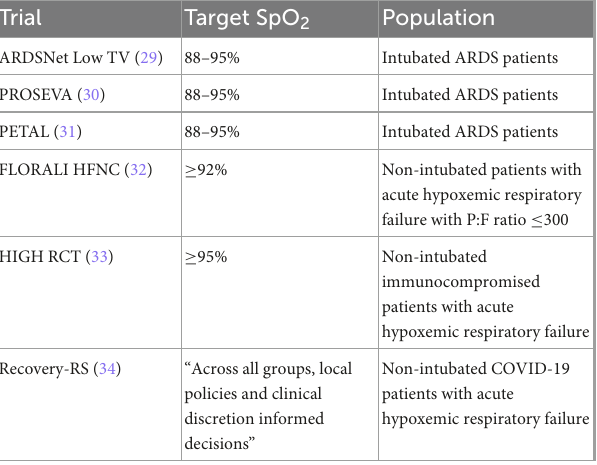
TABLE 1 Oxygen targets used in prior trials enrolling hypoxemic adults.